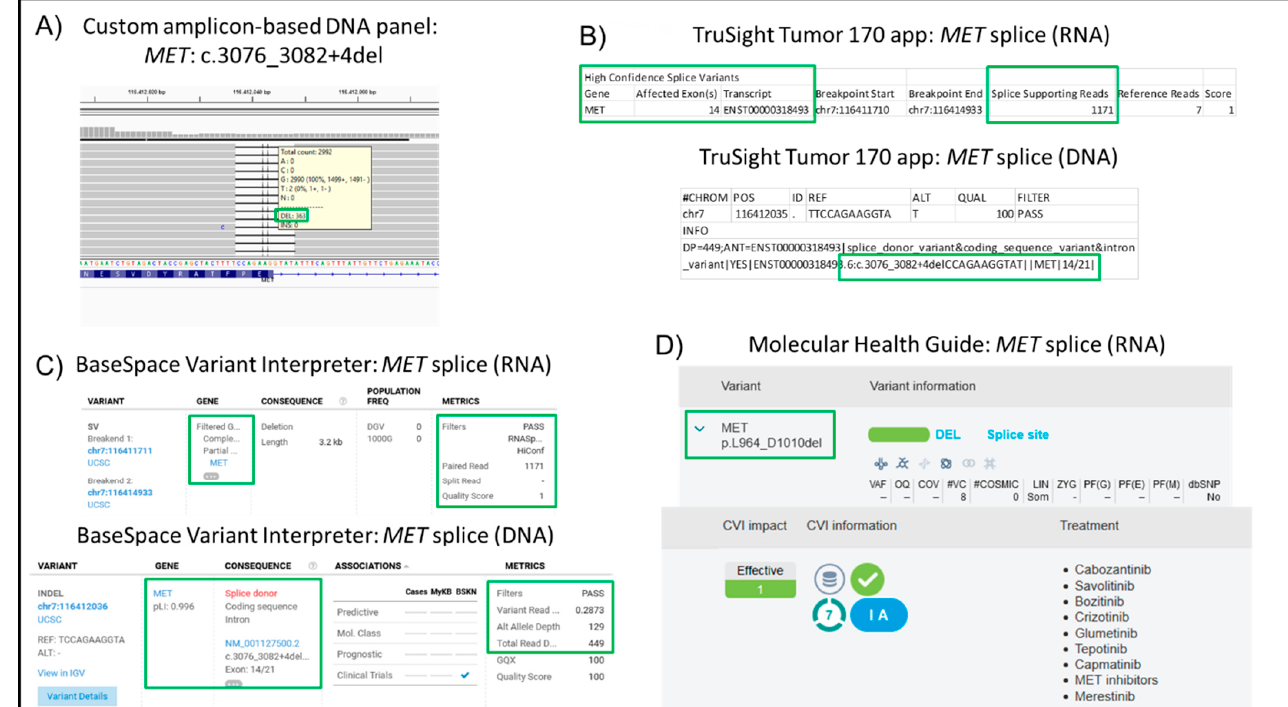
Figure 1. Sample 27 with MET exon 14 skipping mutation. Sequencing was performed with a custom amplicon-based DNA panel and the TruSight Tumor 170 assay. The custom amplicon-based DNA panel was analyzed with an in-house developed pipeline as previously described [6] and visualized with the Integrative Genomics Viewer (Broad Institute of MIT and Harvard, Cambridge, MA, USA) ( A ). The TruSight Tumor 170 assay data was evaluated with the TruSight Tumor 170 app ( B ) on BaseSpace Sequence Hub and the BaseSpace Variant Interpreter ( C ) as well as the Molecular Health Guide Software ( D ). The mutation and the quality criteria are highlighted with a green rectangle for each software.